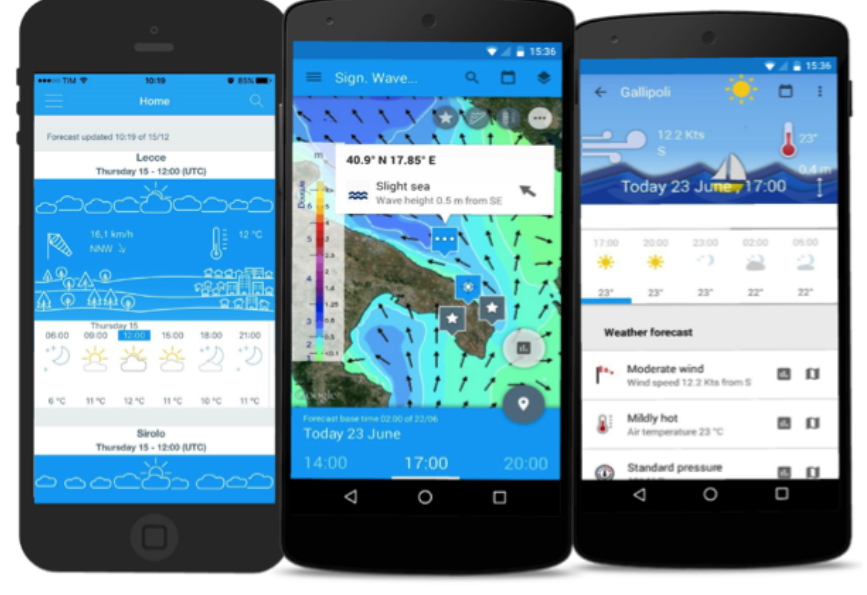
Figure 8. SeaConditions Android mobile app – sample